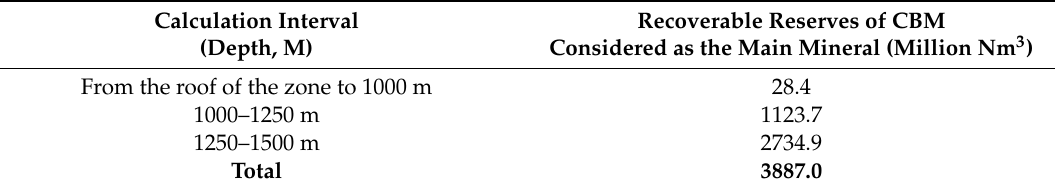
Table 7. Recoverable reserves of CBM considered as the main mineral in the third prospective region. Calculation